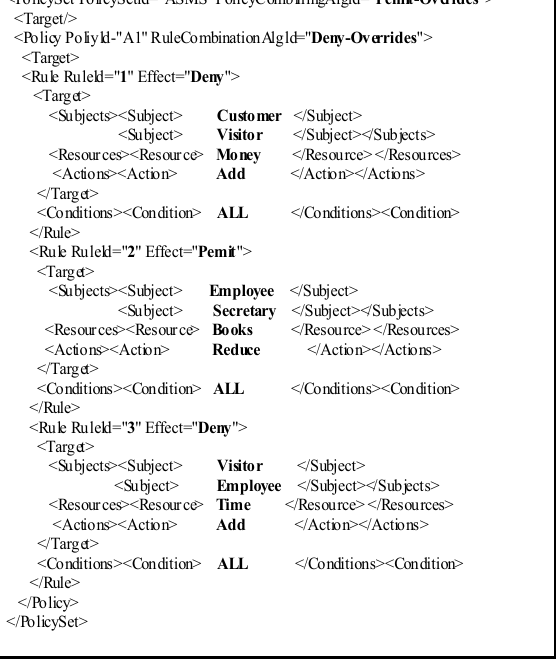
Figure 3. A simple example of an XACML policy set.